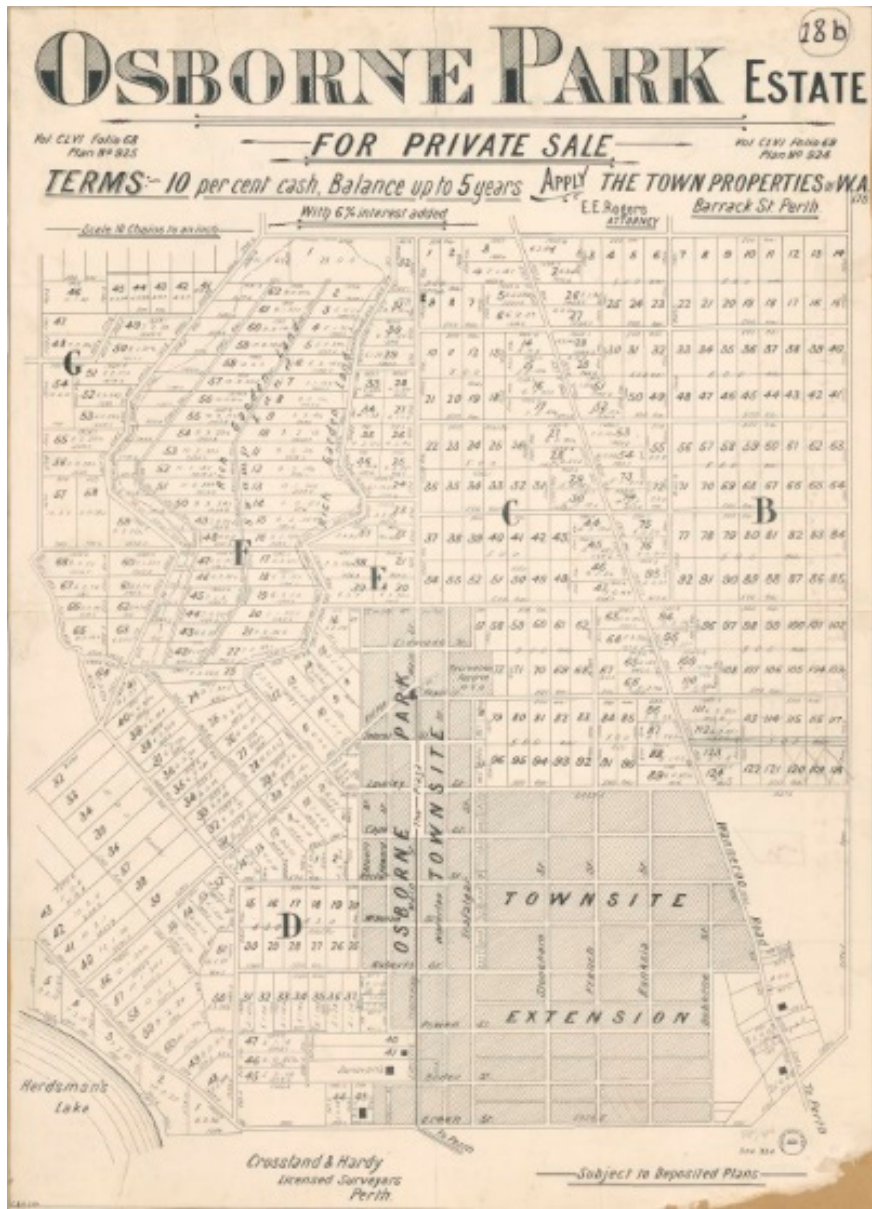
Figure 5. Osborne Park Estate Map. Source: Battye Library.